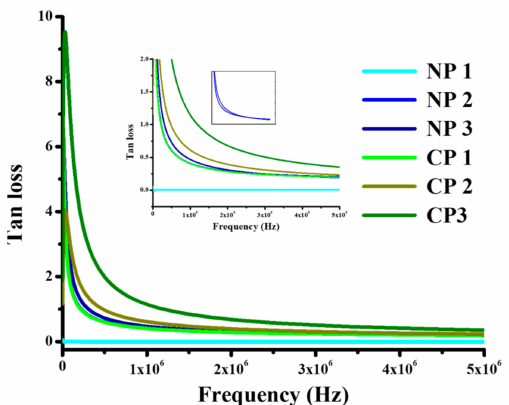
Figure 8. Tan loss, NP1; PVA/NiO (0.01 g), NP2; PVA/NiO (0.02 g), NP3; PVA/NiO (0.03 g), CP1; PVA/CuO (0.01 g), CP2; PVA/CuO (0.02 g), CP3; PVA/CuO (0.03